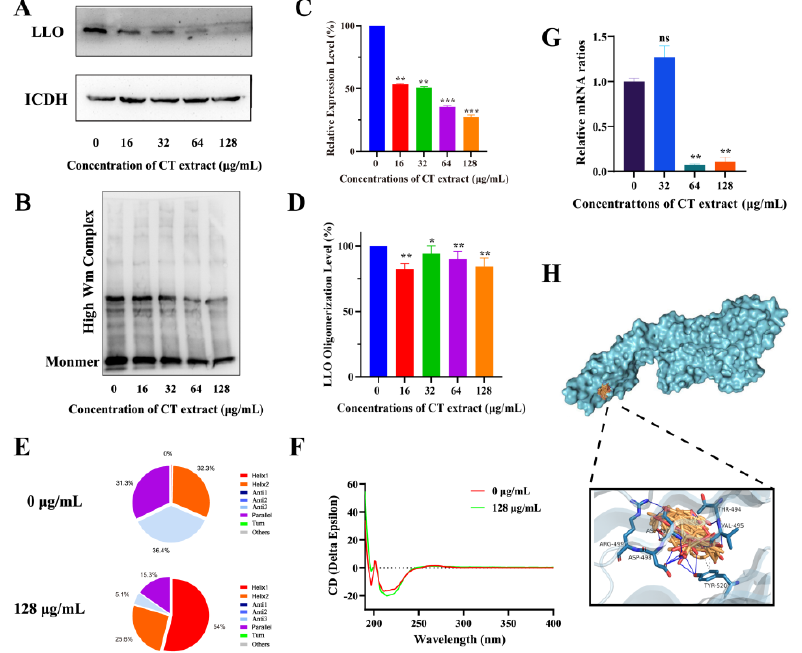
Figure 3. The CT extract inhibition on LLO expression and oligomerization. ( A ) Western blot analysis of the expression of LLO protein in culture supernatant. ( B ) Western blot images were used to observe the effect of CT extract on the oligomerization of LLO. Optical densities of the LLO expression ( C ) and the LLO oligomer level ( D ) were analyzed by ImageJ software. ( E ) Changes in LLO secondary structure with and without CT extraction. ( F ) Circular dichroism of LLO in the presence or absence of CT extract. The wavelength for CD spectroscopy was set as 190–250 nm. ( G ) CT extract inhibited the transcription of hly gene in L. monocytogenes . Bacteria were co-cultured with different concentrations of CT extract and the transcription of hly was evaluated by RT-PCR. ( H ) Molecular docking analysis was performed to predict the potential binding sites of LLO (4CDB) and ingredients of CT extract. The main components of CT extract binding with LLO pockets were viewed as a blue-grey surface. The ingredients were displayed in a stick model with carbon atoms in yellow and oxygen atoms in red. The binding site is mainly a hydrophilic binding pocket, and the hydrophilic residues were THR494, VAL495, TYR520, ASP497, ASP498 and ASP499. ** p < 0.01 compared to the positive group. Ns, not significant.